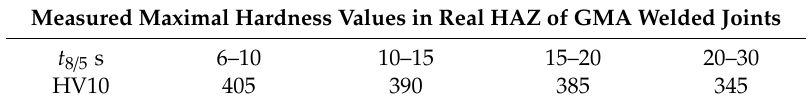
Table 3. Measured maximal hardness values of gas metal arc (GMA) welded joints from S960QL steel.